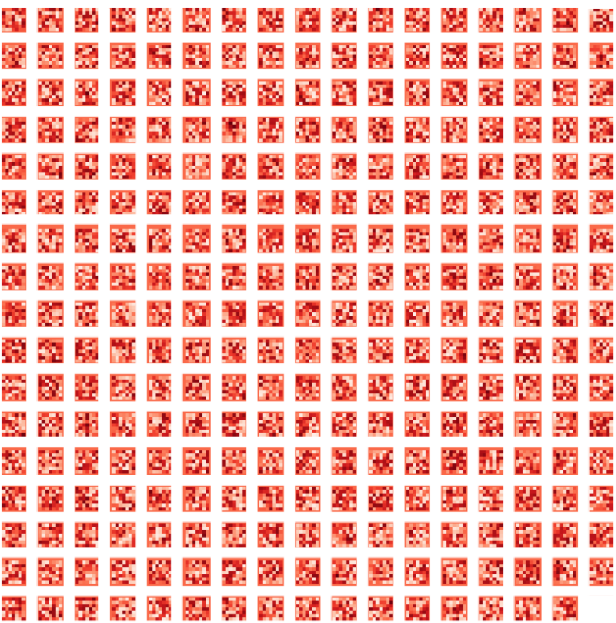
Figure 3. All learned filters of the first convolutional layer.